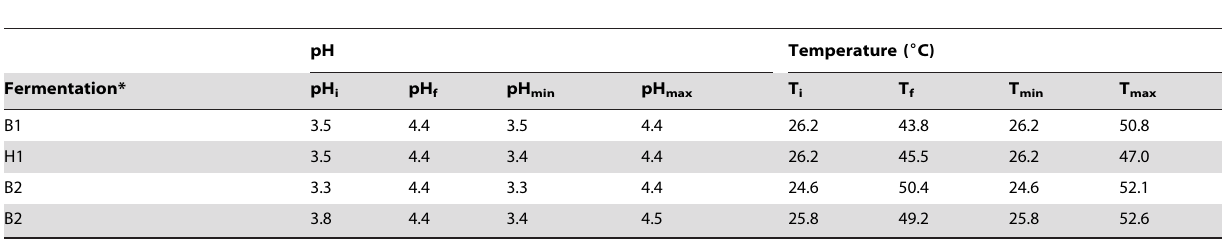
Table 1. Temperature and pH of cocoa pulp in four Malaysian spontaneous cocoa pulp fermentations.